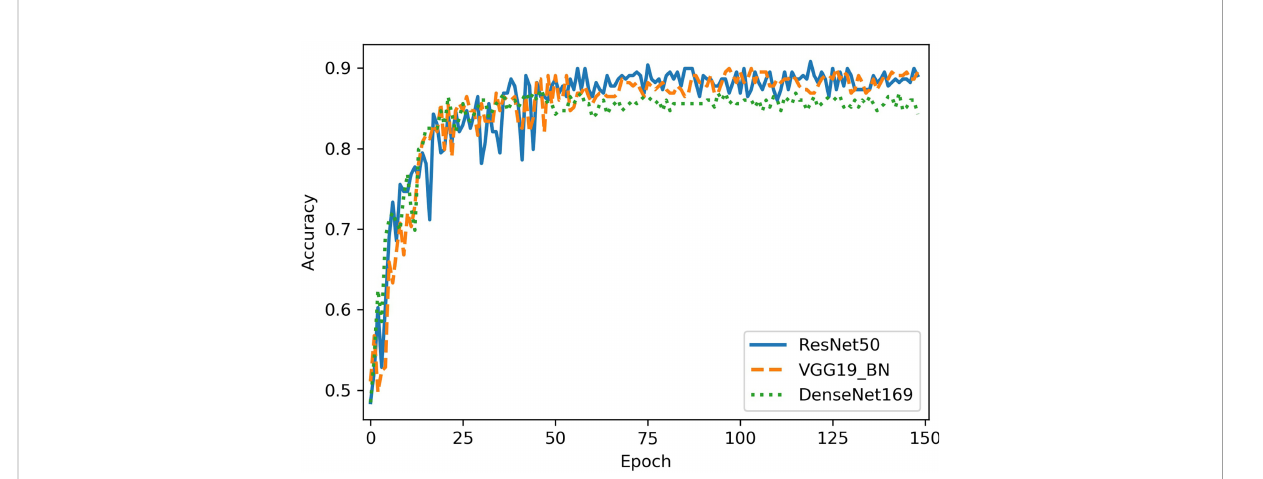
FIGURE 4 The diagnostic accuracy of Resnet50, VGG16_bn, and DenseNet169 in test set. The horizontal axis represents the training epochs, and vertical axis represents diagnostic accuracy. The best accuracy of ResNet50 is higher than VGG16_bn and